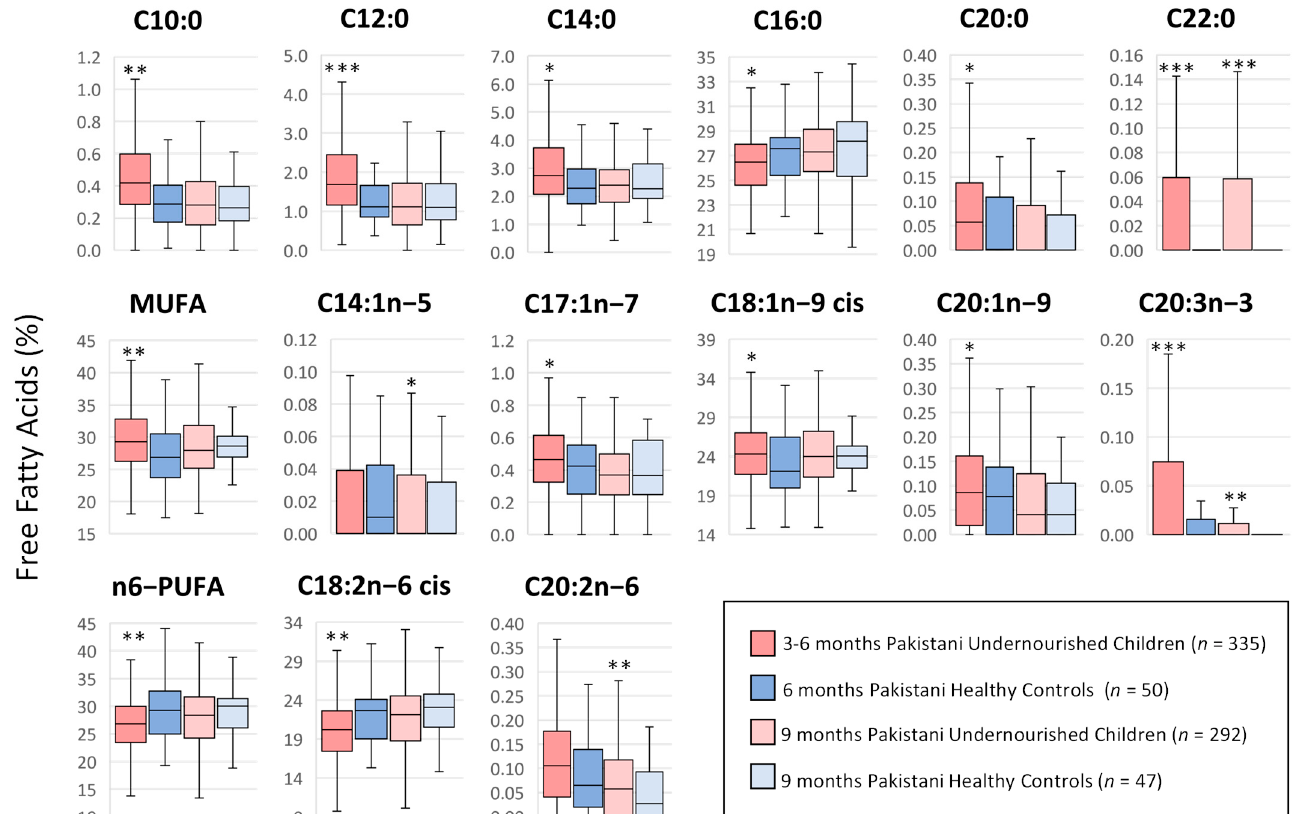
Figure 2. Proportions (%) of serum non-esterified fatty acids in Pakistani undernourished and healthy children at two study time points. Median values and interquartile ranges are shown in boxplots. Differences in each characteristic were evaluated by corresponding t -test. *** p < 0.0001 compared with the healthy control group at the corresponding time point. ** p < 0.01 compared with the healthy control group at the corresponding time point. Median values and interquartile ranges are shown in boxplots. * p < 0.05 compared with the healthy control group at the corresponding time point. More specific information is included in Supplementary Table S1.